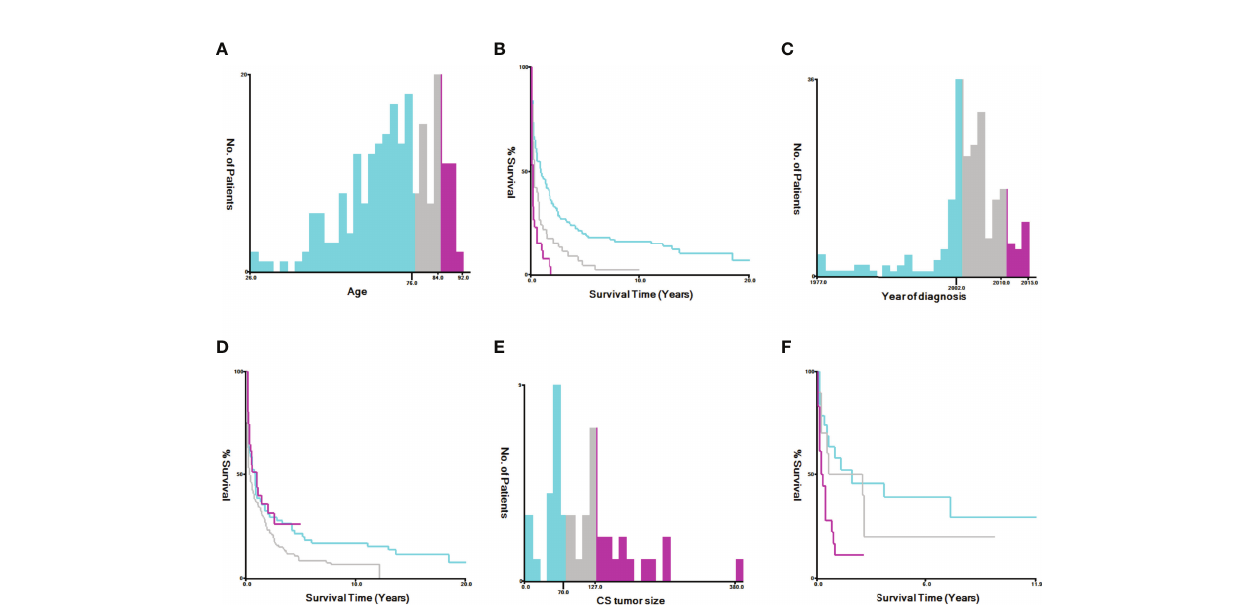
FIGURE 2 | Identi fi cation of optimal cut-off values for age [ (A) best cut-off value for age, (B) survival curves for different ages, (C) best cut-off value for tumor size, and (D) survival curves for different tumor sizes] and year of diagnosis [ (E) best cut-off value for tumor size, (F) survival curves for different tumor sizes] via X-tile software analysis. The optimal minimum and maximum cut-off values for age (based on overall survival) are 76 and 84 years, those for tumor size are 70 and 127 mm, and those for the year of diagnosis are 2002 and 2010,